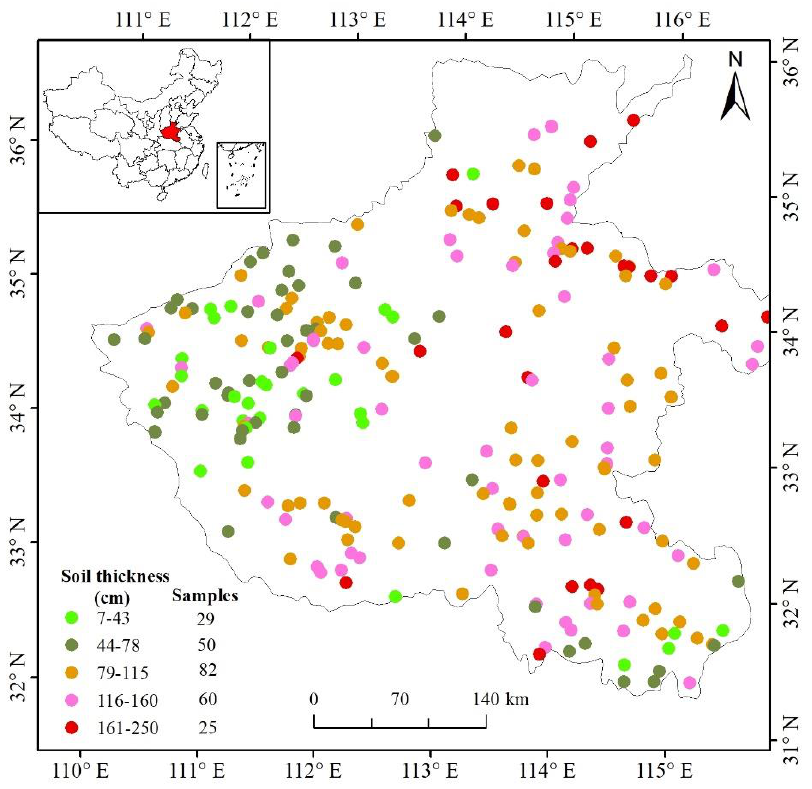
Figure 1. Location of study area and soil sampling plots.